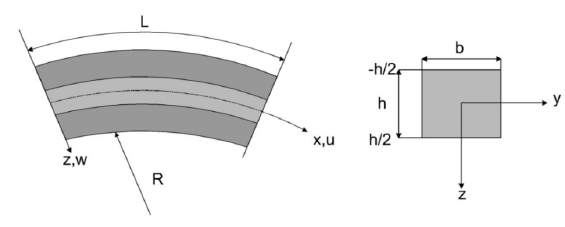
Figure 1: Geometry ad coordinates system of laminated curved